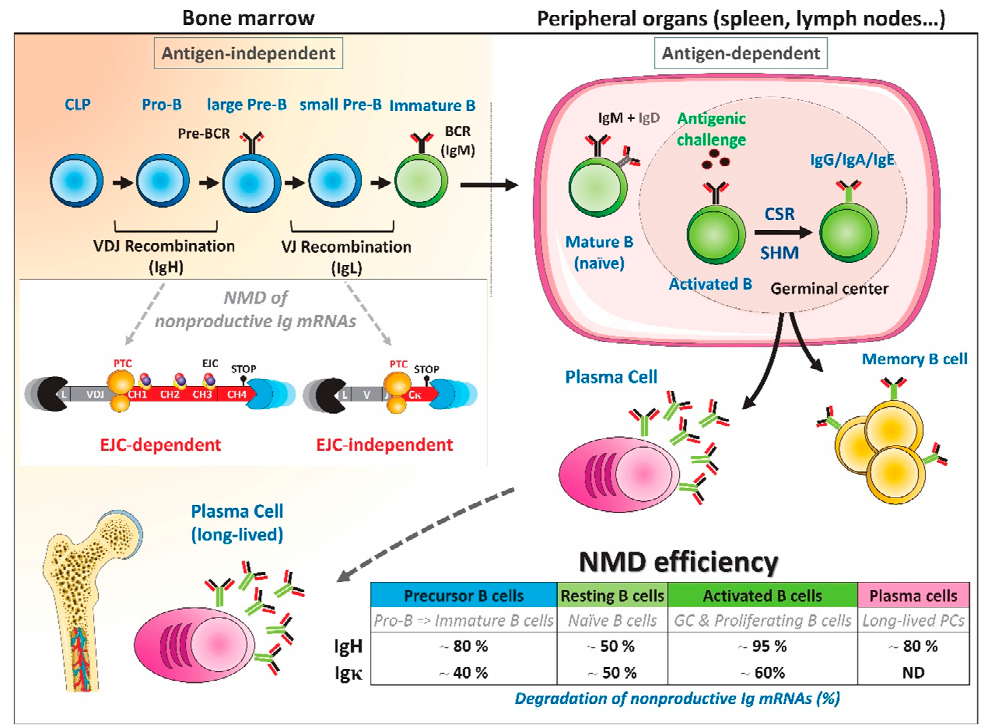
Figure 2. NMD assessment during B-cell development. Early B-cell development takes place in bone marrow through antigen-independent stages. B cell precursors undergo a first round of DNA rearrangements, between VH, DH, and JH segments located in the 5 (cid:48) region of the Ig heavy (IgH) chain locus. V(D)J recombination is initiated by DH to JH rearrangements at the pro-B stage and followed by VH to DJH recombination. At the large pre-B stage, a productive (P) VDJ rearrangement encodes membrane Ig µ chains that can associate with surrogate light chains to form the pre-B cell receptor (pre-BCR). Provided appropriate pre-BCR signaling, V to J rearrangements will be initiated at Ig light chain loci in small pre-B cells, leading to the expression of a functional BCR at the immature B cell stage. Once positively selected, mature B cells migrate to the periphery. Upon antigen stimulation, B cells proliferate in germinal centers (GCs) and further diversify their Ig repertoire through class switch recombination (CSR) and somatic hypermutations (SHM). Activated B cells can then di ff erentiate into memory B cells or plasma cells (PCs). PCs will return to bone marrow niches in which they can survive for several years. Mouse models have been used to quantify the extent of degradation of nonproductive (NP) Ig mRNAs during B-cell development [94,97]. Fluctuations of NMD e ffi ciency are depicted in the lower right table. A very active EJC-dependent NMD is elicited for NP IgH mRNAs, with almost complete disappearance of PTC-containing IgH mRNAs in activated B cells [97]. In contrast, the magnitude of EJC-independent NMD is far lower for NP IgL mRNAs, with only 60% of degradation in activated B cells [94]. ND: not